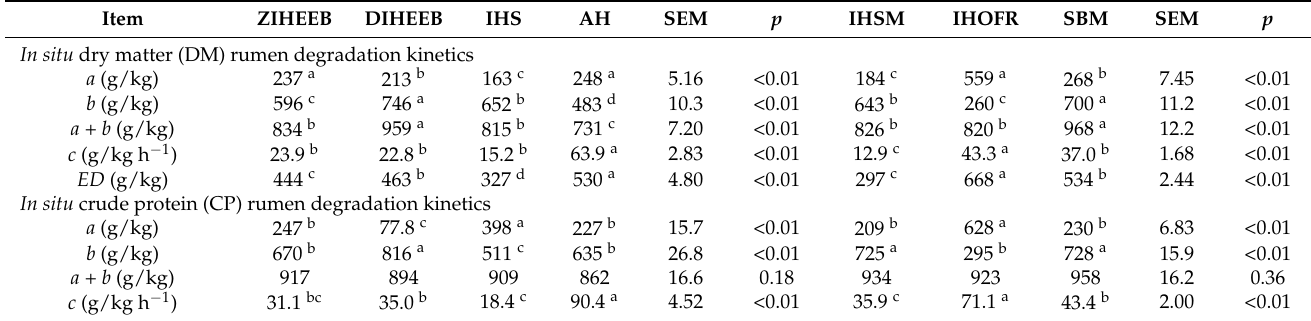
Table 3. In situ ruminal degradation kinetics in industrial hemp byproducts and conventional